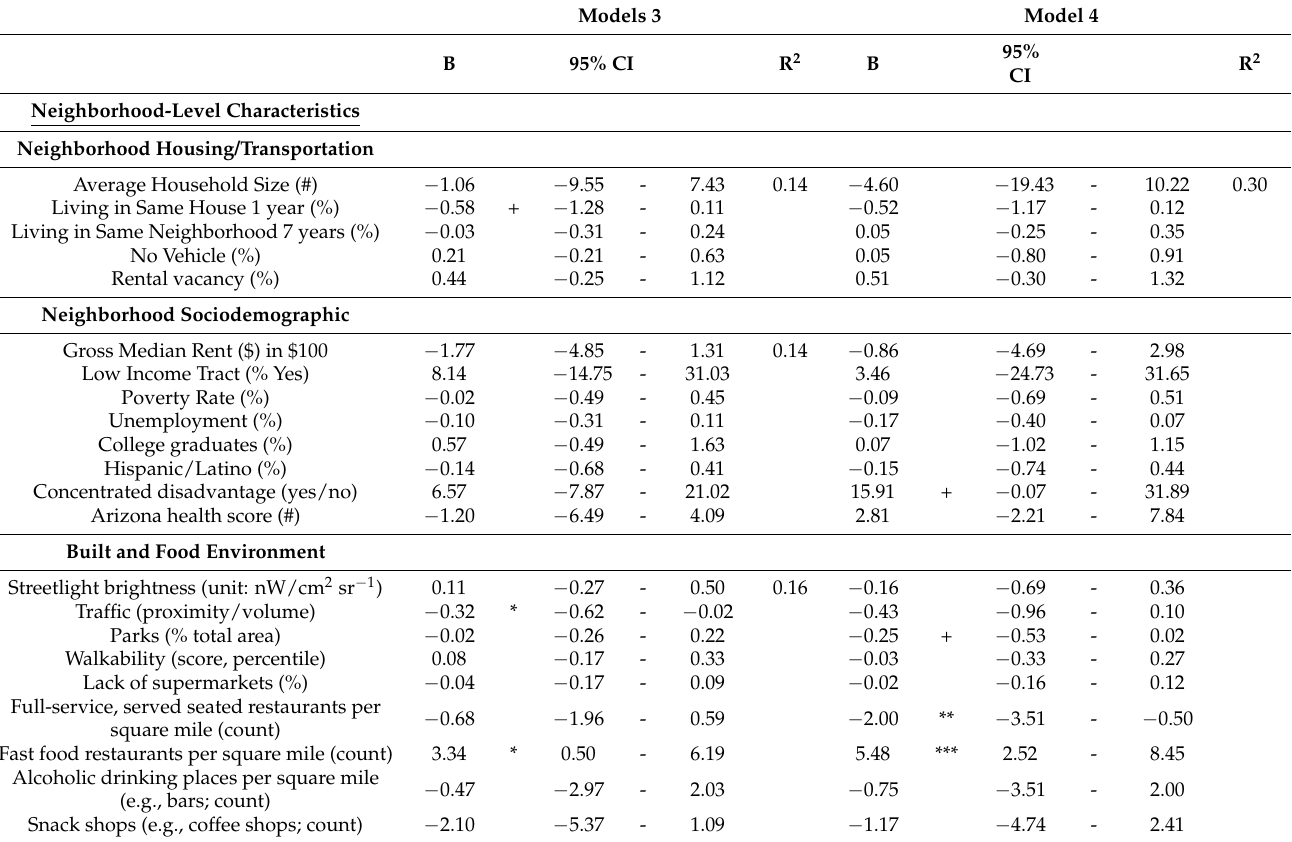
Table 3. Coefficients from ordinary least squares regression models predicting 2-h glucose; joint neighborhood associations among Latino youth ( n = 133),